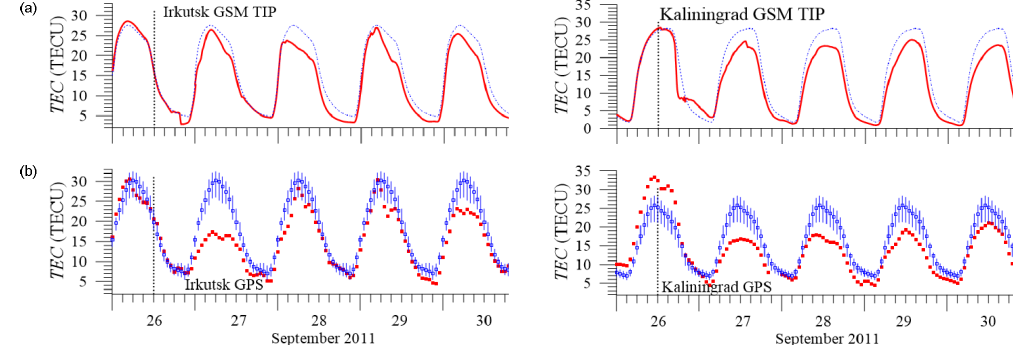
Figure 3. The same as in Fig. 2, but for the TEC calculated from the GSM TIP and derived from the GPS receiver.